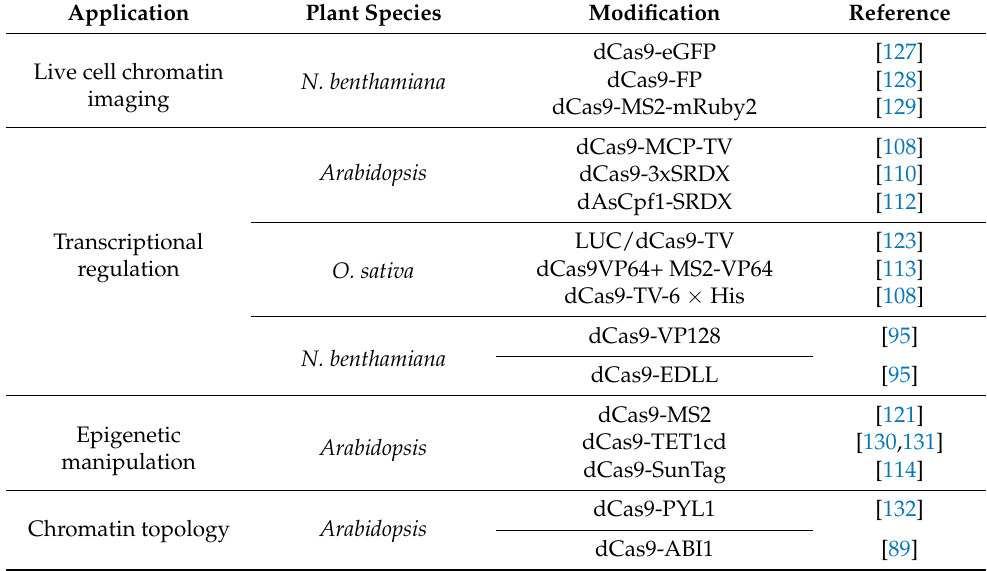
Table 2. Application of CRISPR/dCas9 in